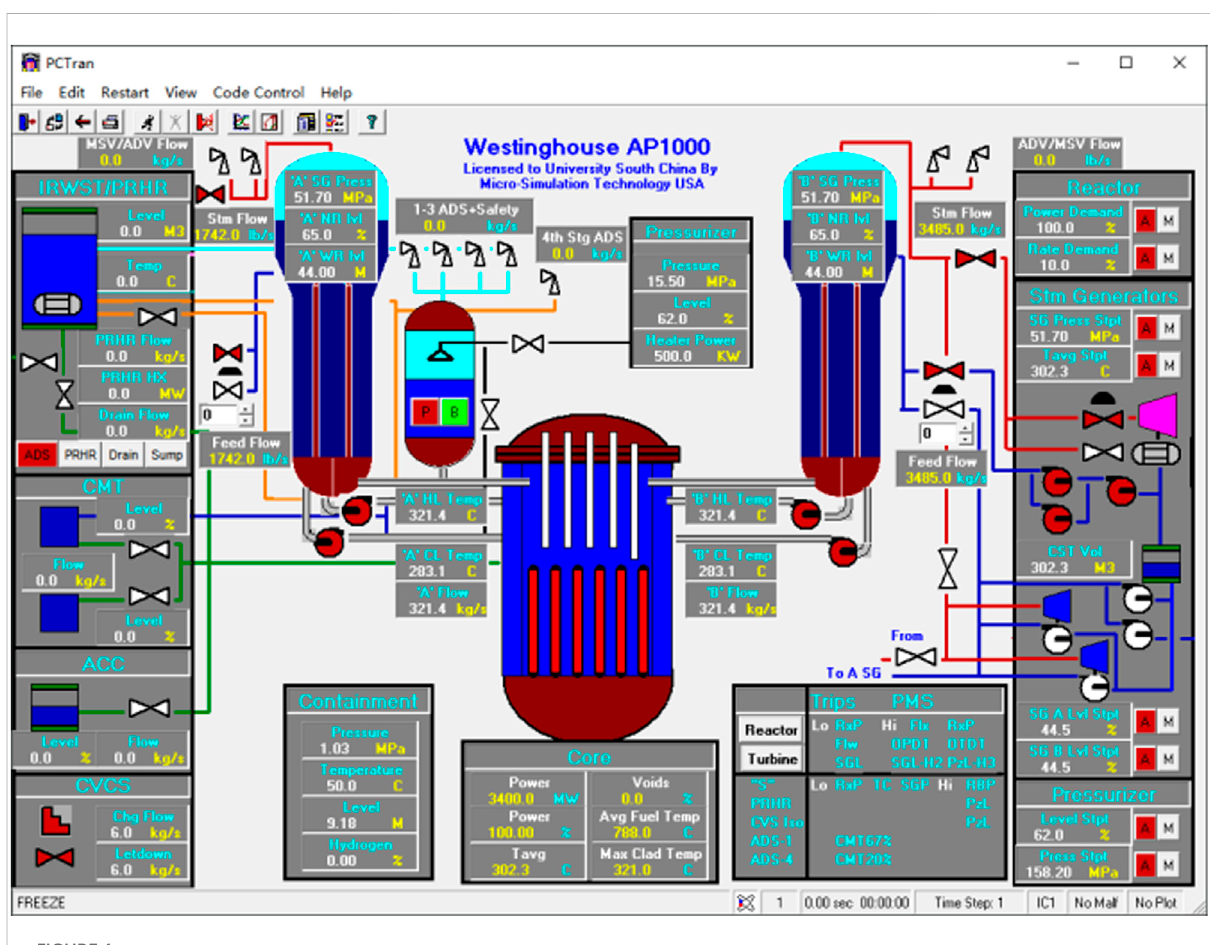
FIGURE 1 Main interface of